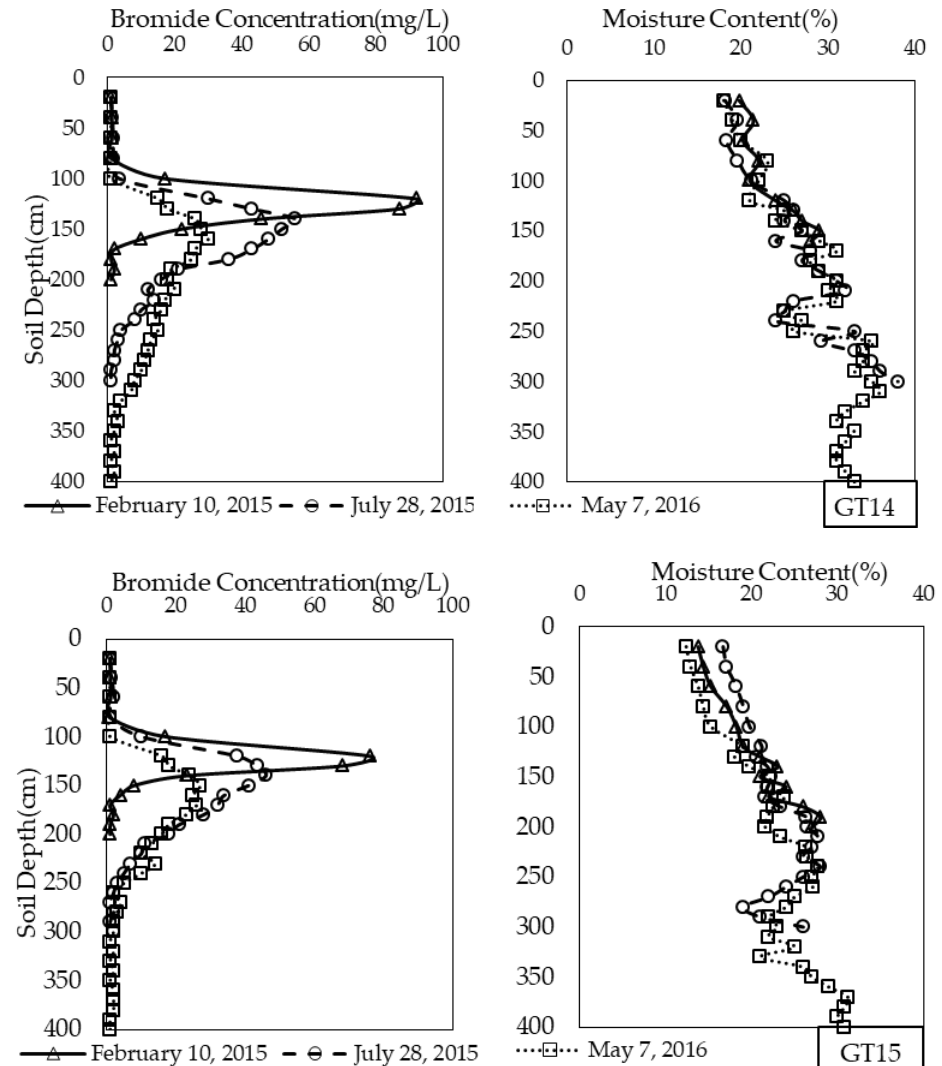
Figure 4. Bromide concentration and moisture content in typical sites.